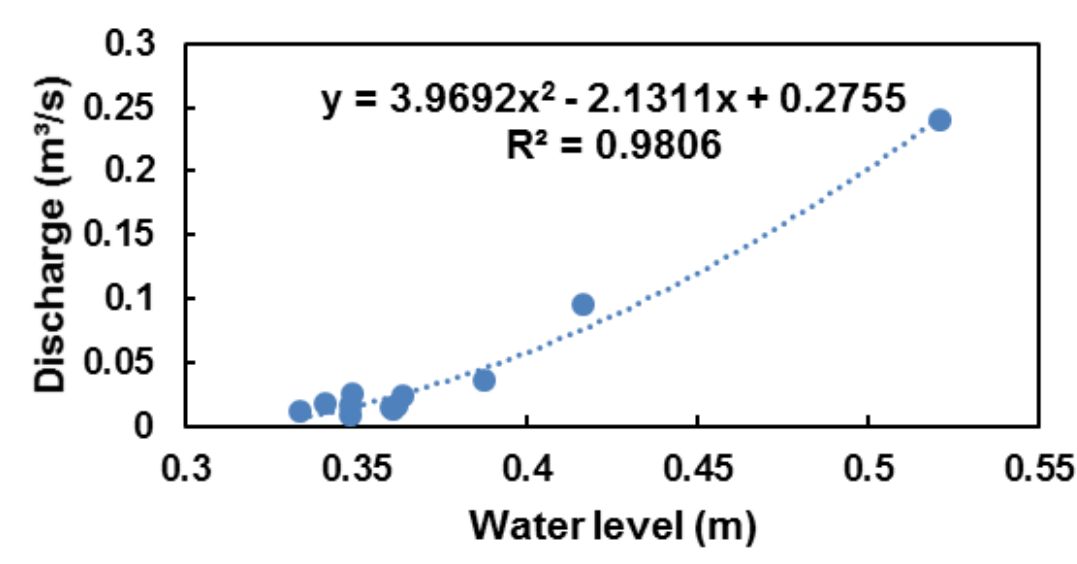
Figure A2. An example of rating curve: upstream of Basin A. Points correspond to spot flow measurements taken during the field